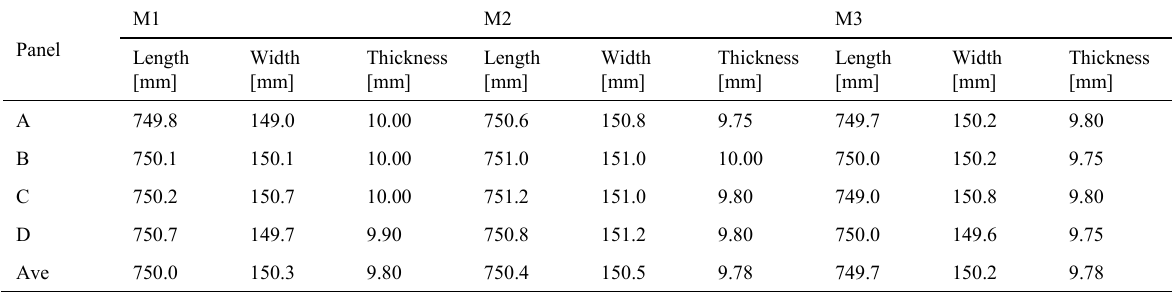
Table 2: Actual dimensions of LG